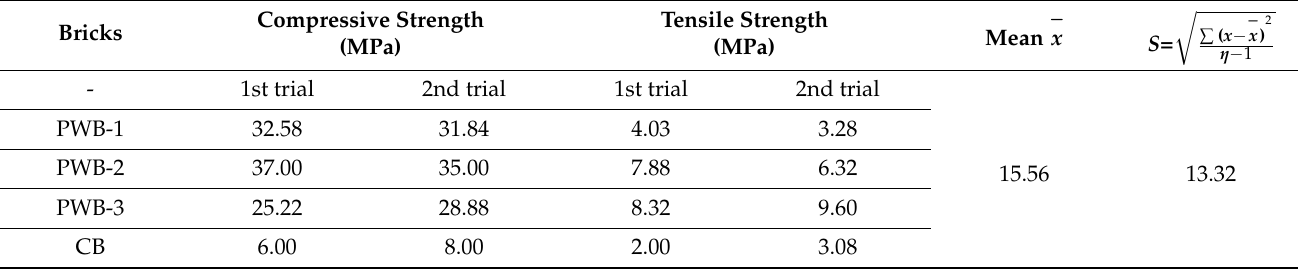
Table 2. Standard deviation of the